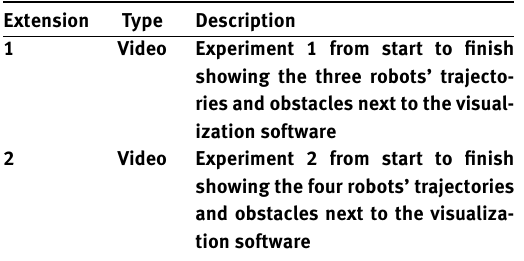
Table 8. Table of Experiment 2 pairwise parameters. Robot Robot